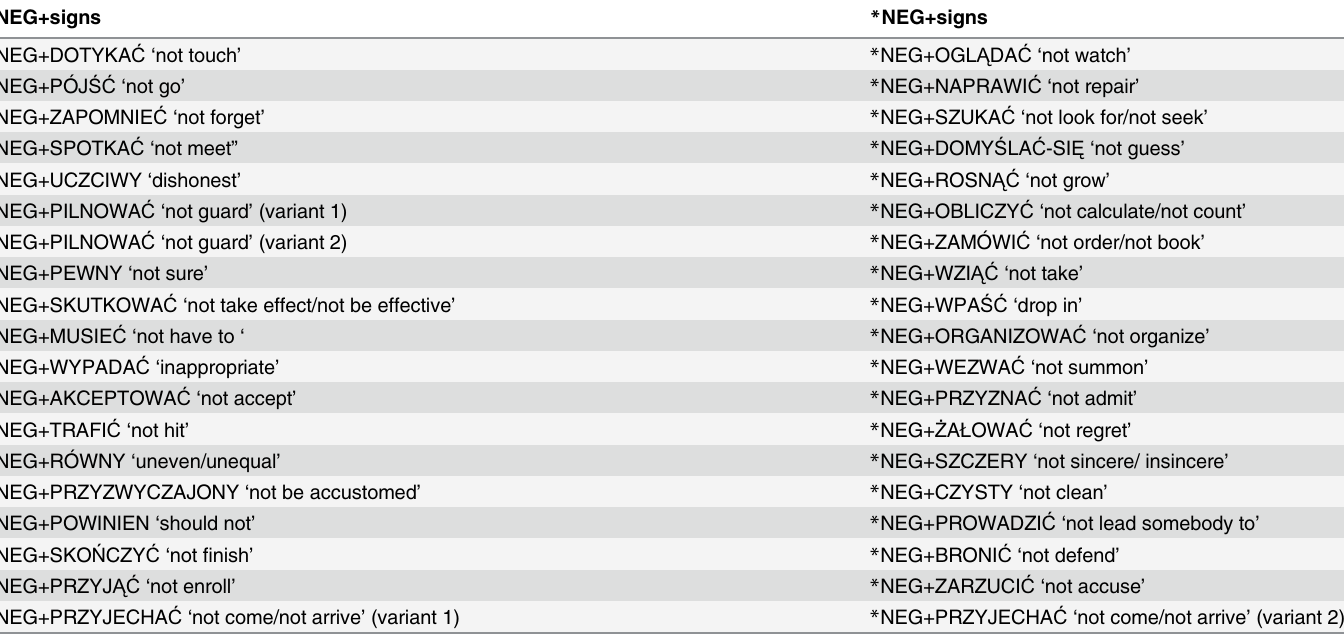
Table 3. Signs that can (left column) and cannot (right column) take the prefix NEG-.